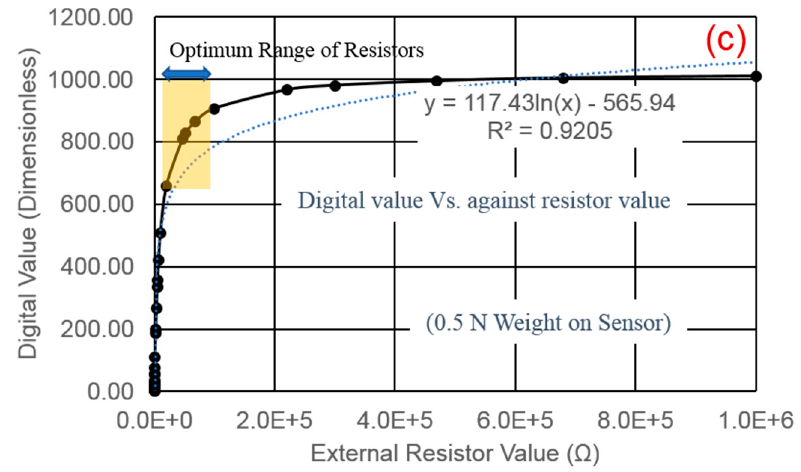
Figure 8. Optimization of external resistor for user desired force measurement system. ( a ) Schematic potential divider between external resistor and internal resistor; ( b ) experimental setup and circuit diagram; and ( c ) Digital values Vs external resistor.